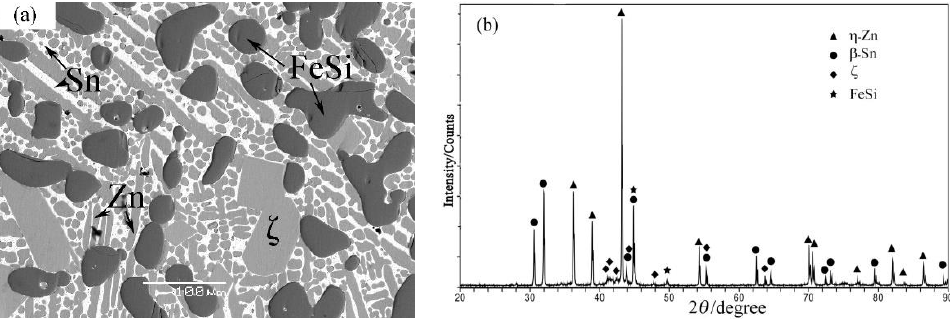
Figure 3. The microstructure ( a ) and the XRD pattern ( b ) of Alloy A2.